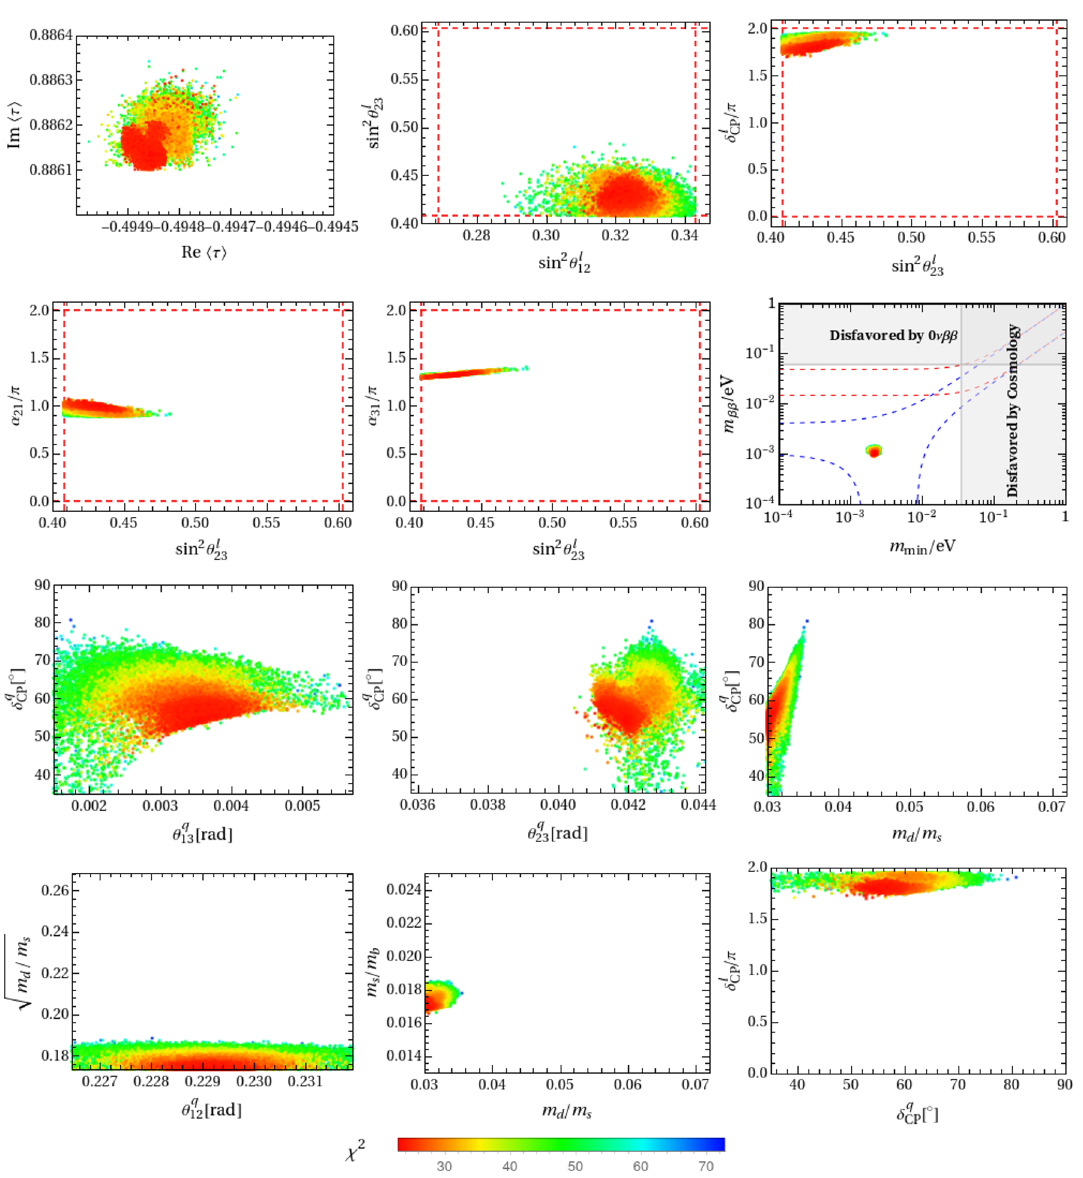
Figure 6 . The values of the complex modulus τ compatible with experimental data and the correlations between the neutrino mixing angles, CP violation phases, quark mass ratios and mixing parameters for the model BM1 with thermal initial condition. The vertical and horizontal dashed lines are the 3 σ bounds taken from [110]. Note that the contribution of Y B to χ 2 is not included here. cisely calaulate the final lepton asymmetry for arbitrary right-handed neutrino mass spec- trum. The right-handed neutrino masses are hierarchical with M 10 9 GeV (cid:28) M (cid:28) 10 12 GeV in our benchmark models. Hence the decays of N 1